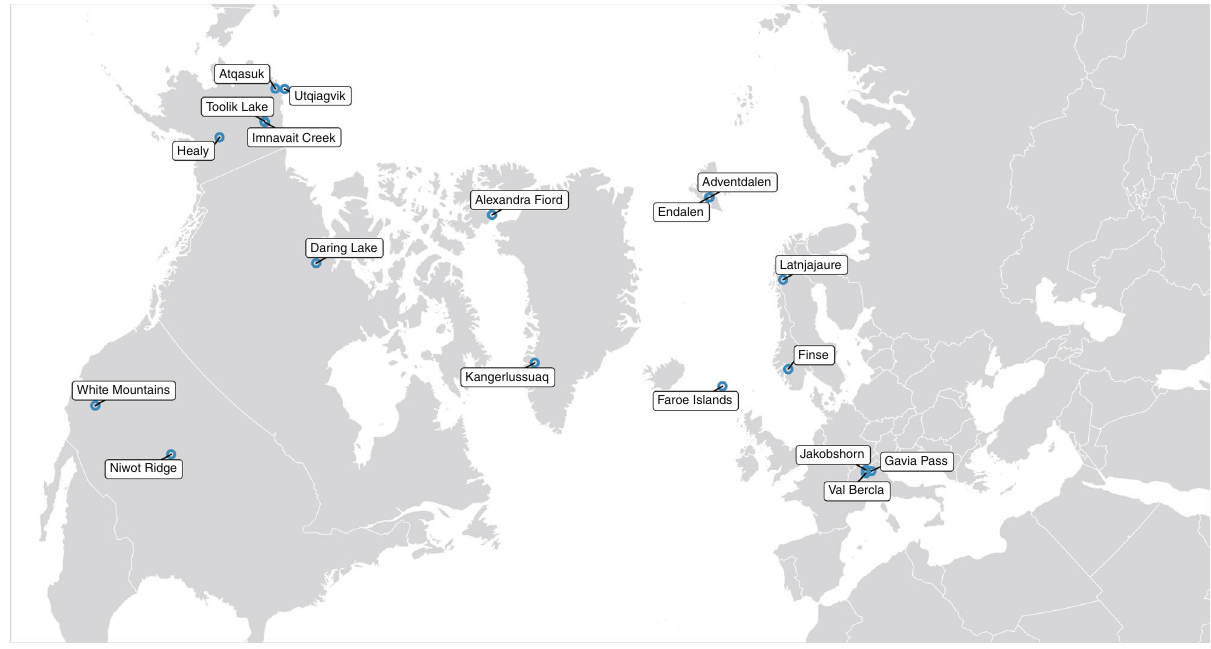
Fig. 2 Map of study sites. Map of 18 sampling sites across the ITEX network with warming (OTC) experiments included in this analysis. Created using the sf package (v 0.9.6) 105 in R. Table 1 Bayesian hierarchical modeling estimates and credible intervals (90, 95% eti low, high) for the effects of OTC warming on 6 plant